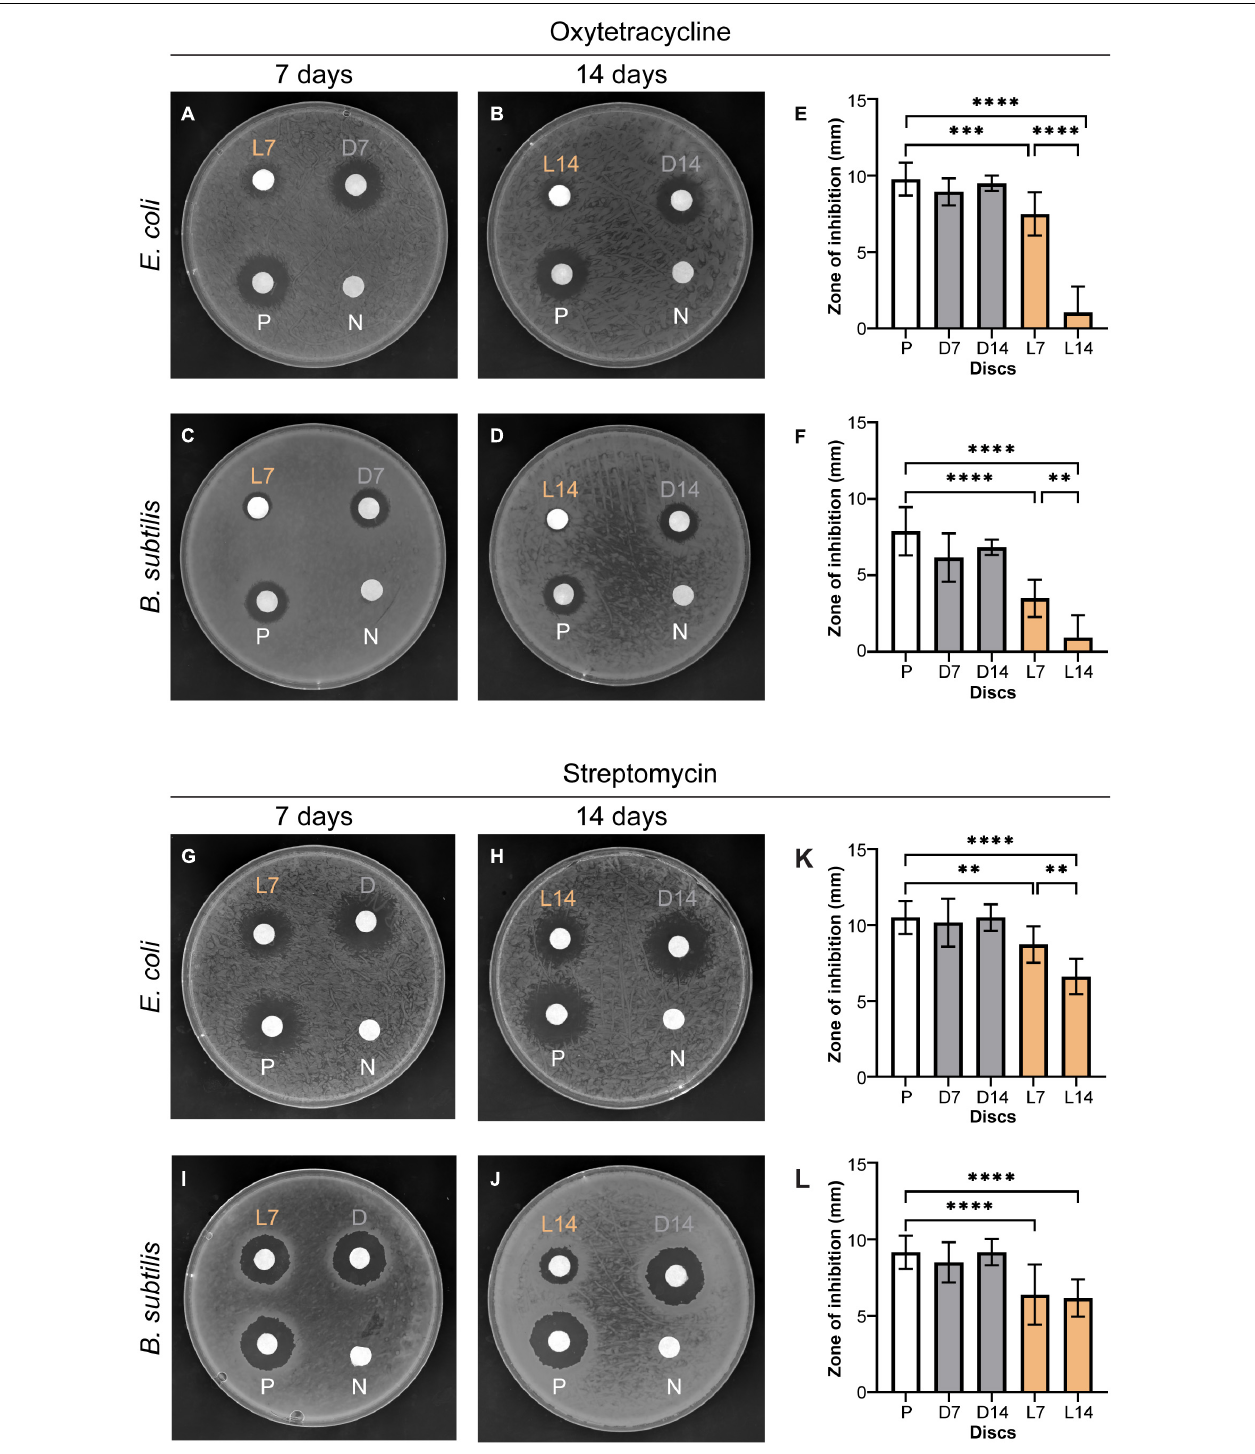
FIGURE 1 | Oxytetracycline and streptomycin lose antibiotic potential in the presence of sunlight. Shown are representative disc-diffusion assay results for the effects of oxytetracycline (A–D) or streptomycin (G–J) on growth of either Gram-positive B. subtilis or Gram-negative E. coli . Quantification of the zones of inhibition in millimeters are plotted for each 7- or 14-day cohort of oxytetracycline (E,F) and streptomycin (K,L) . Significance was determined using a one-way ANOVA with Tukey’s multiple comparisons analysis. Error bars represent standard deviation (SD) of the mean from three biological replicates. N: negative control (discs prepared with sterile water), P: positive control (discs prepared the day of testing), L7 or L14: 7 or 14 days in sunlight, D7 or D14: 7 or 14 days in darkness. ∗∗∗∗ p < 0.0001, ∗∗∗ p < 0.001, ∗∗ p < 0.01.